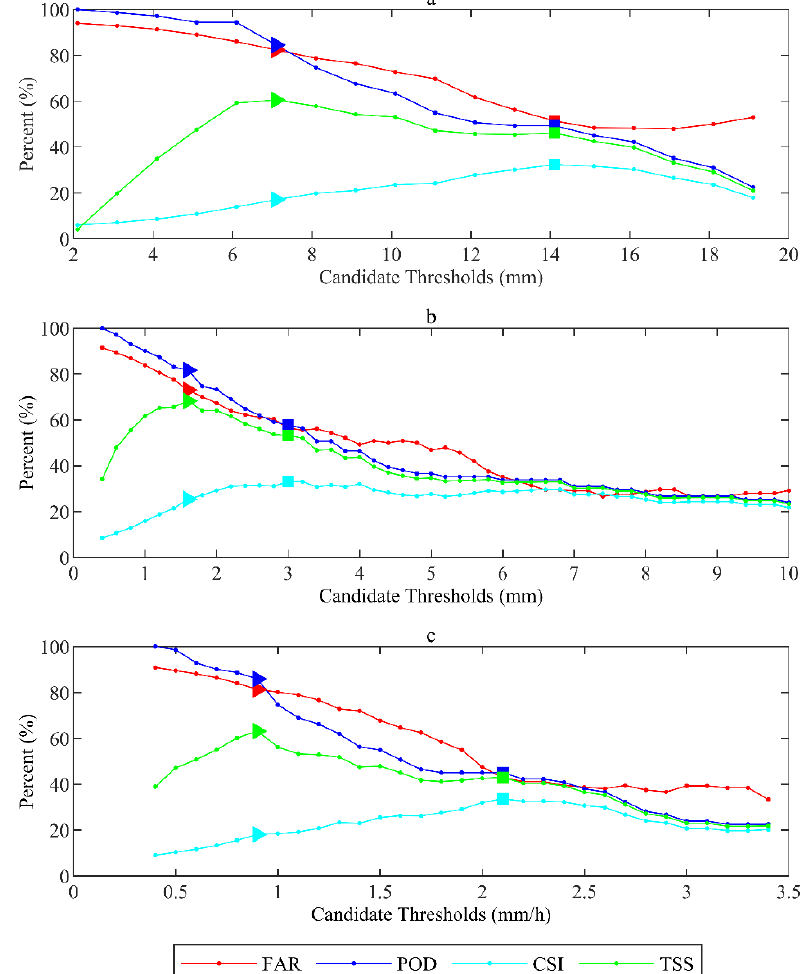
Figure 3. Percentage of POD, FAR, CSI, and TSS candidate thresholds at the 724988-94704-NYDV station in January over the period of 2010 – 2018. ( a – c ) The results of PWV value, PWV increase, and maximum hourly PWV increase, respectively. The triangles and squares are the results determined by TSS and CSI, respectively.